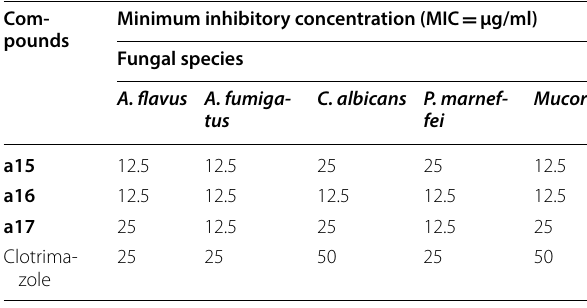
Table 10 Pharmacological evaluation (MIC